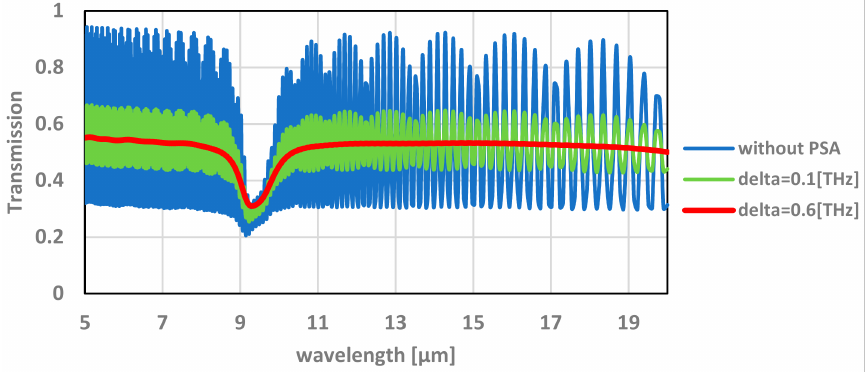
Figure 5. Simulations results for the transmission of the TMOS optical window as a function of the wavelength. PSA: partial spectral averaging ( δ : delta, see Section 4.3).